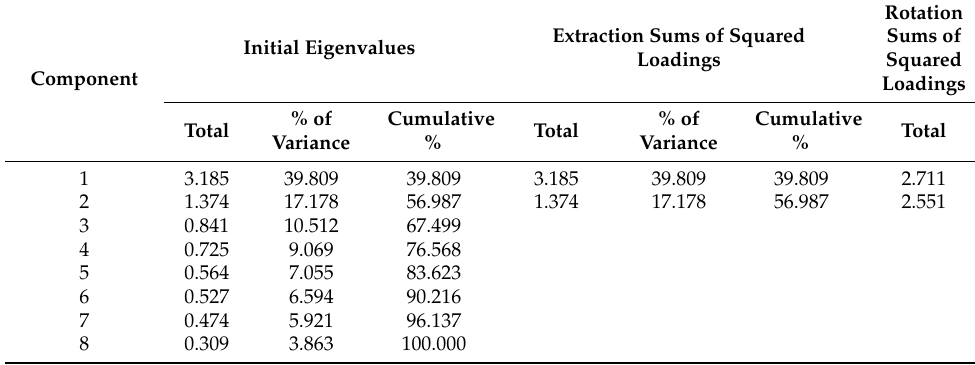
Table 6. Eigenvalues and total variance explained by the EFA model.